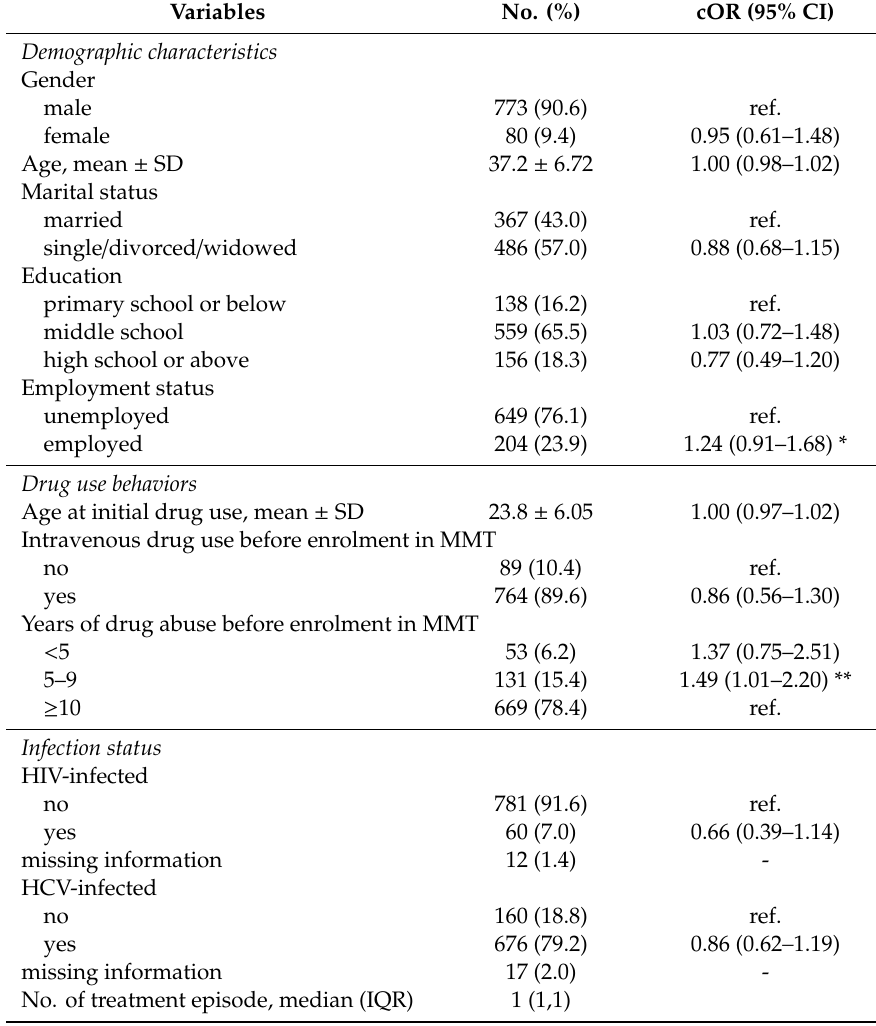
Table 1. Characteristics of MMT (methadone maintenance treatment) participants and univariable regression results of heroin abstinence (level 2, N =